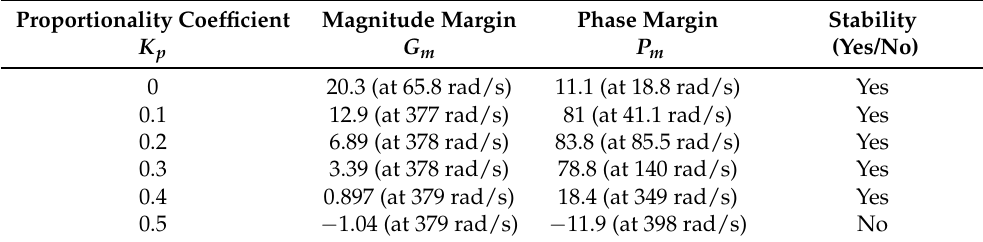
Table 1. The characteristics with different proportionality coefficients. Proportionality Coefficient Magnitude Margin Phase